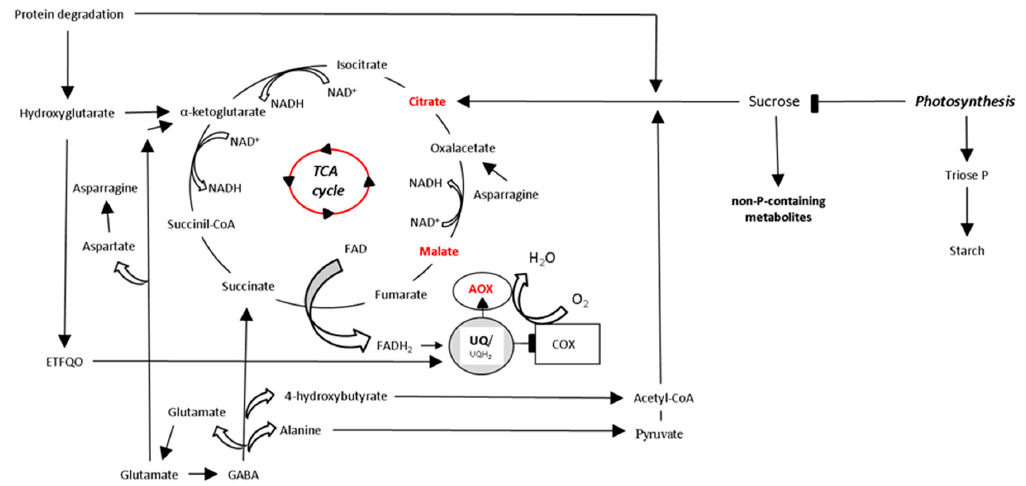
Figure 1. Schematic representation of the TCA cycle and its connection with Pi consumption in leaves of plant species adapted to P deficiency. Low Pi availability limits both photosynthesis and respiration. In chloroplasts, the export rate of the Calvin-Benson cycle products, which are needed for